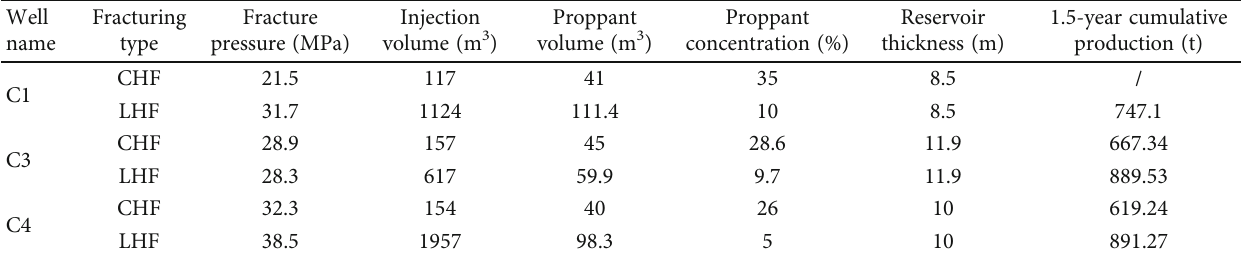
Table 2: Fracturing construction parameters.